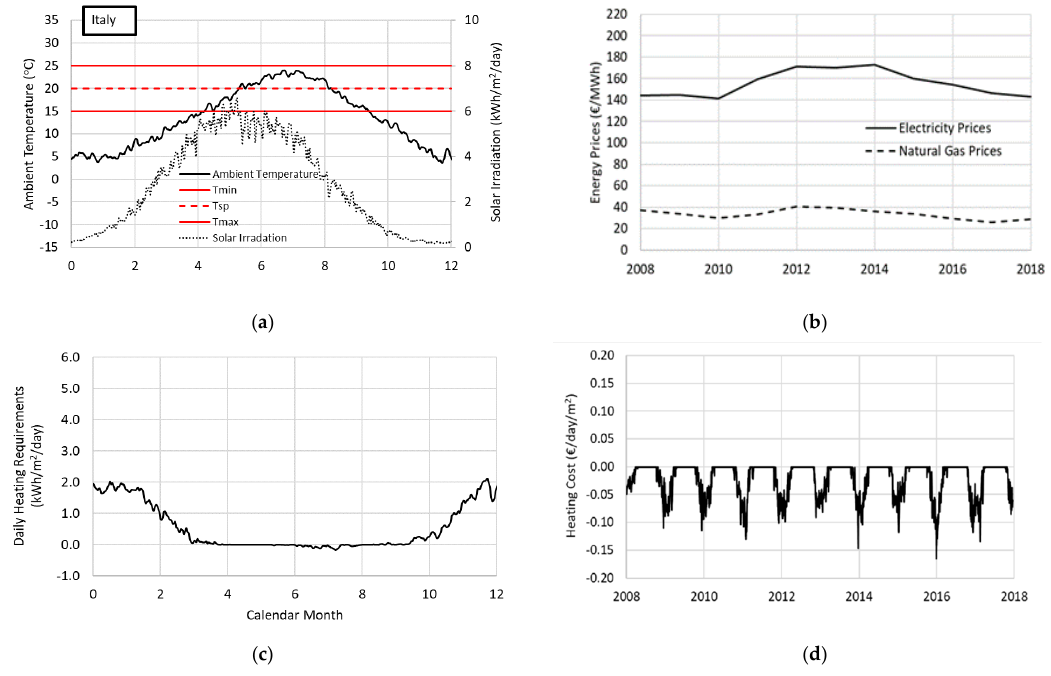
Figure 10. Evolution of seasonal greenhouse energy cost in Italy during the 2008–2018 period. Summarized results of ( a ) climatic conditions, ( b ) evolution of energy prices, ( c ) energy requirements, and ( d ) evolution of energy cost.